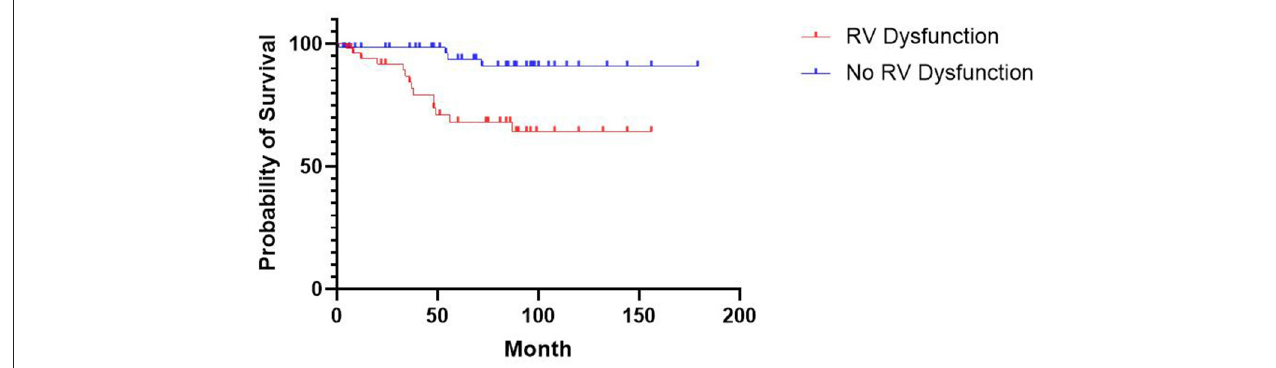
FIGURE 2 | Kaplan-Meier Estimates of Survival According to RV Dysfunction. The difference in survival between patients with and without RV dysfunction was statistically significant ( P = 0.0013 by the log-rank test).